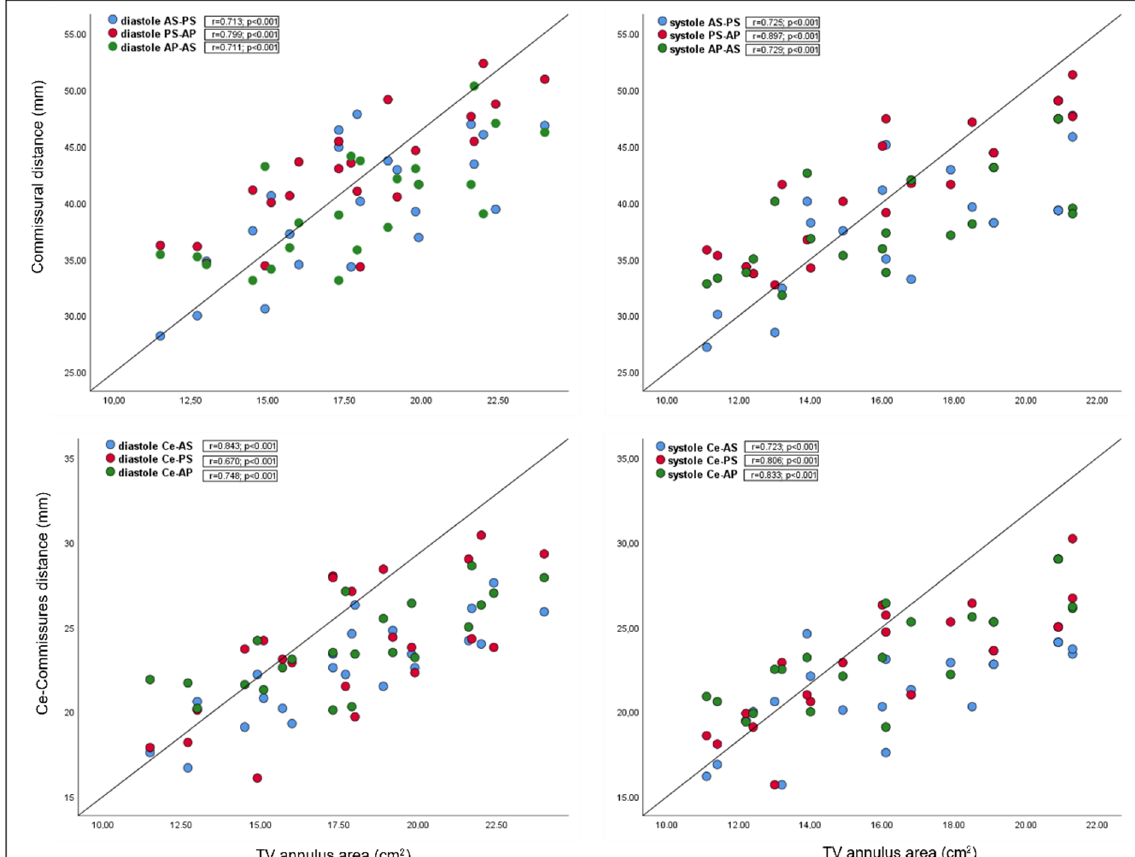
Figure 3. Correlations between the TV annular area and novel annular dimensions (distance between commissures and distance between centroid and commissures) in diastole (left panel) and systole (right